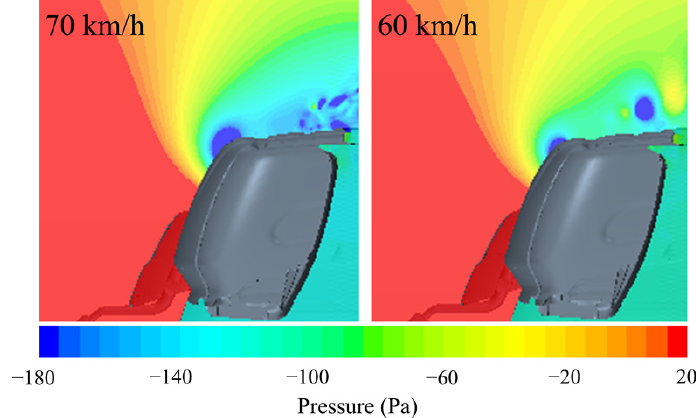
Figure 9. The pressure contour curve of the cab forehead with different speed. Figure 10 is a contour curve of the cab pressure when the inlet speed was 60 km/h.